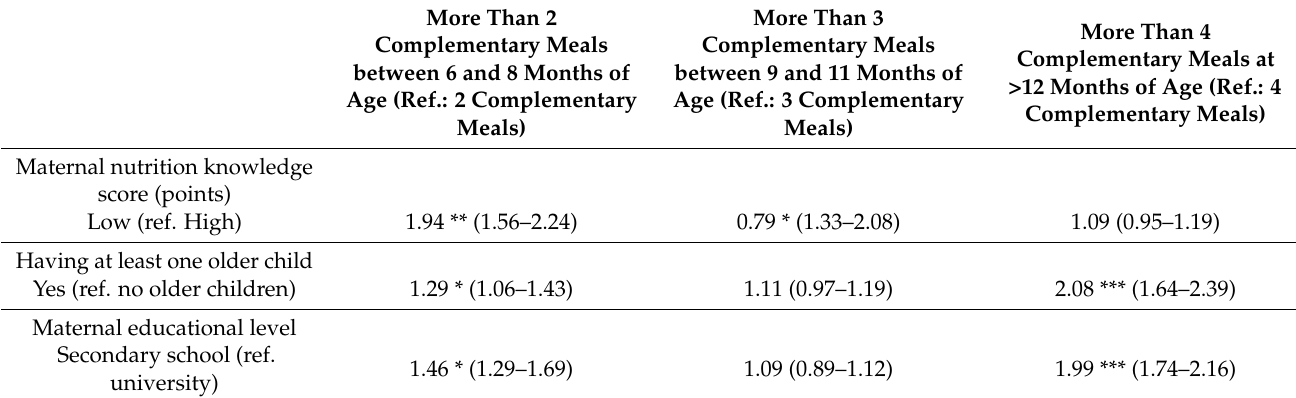
Table 4. Odds ratios (95% confidence interval). The associations between maternal factors and the number of complementary meals.